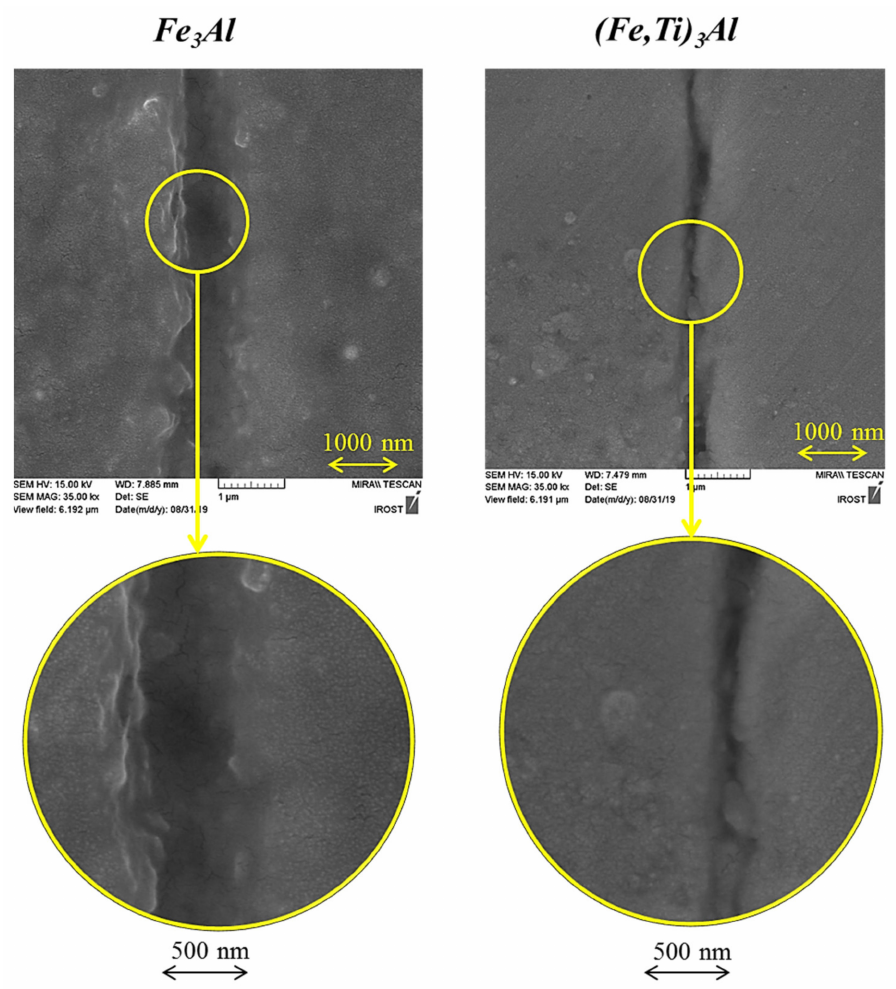
Figure 12. SEM images from scratch grooves in Fe 3 Al and (Fe,Ti) 3 Al